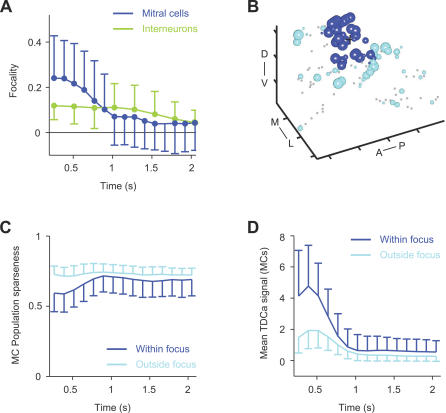
Focality of Activity Patterns and Local Sparsening(A) Mean focality (± SD) of MC and IN activity patterns as a function of time (datasets 1 and 2). Dots indicate significant differences (p < 0.05) from the focality of randomized patterns.(B) Assignment of MCs to the focus illustrated by three-dimensional activity pattern 256 ms after response onset (Lys, same as in Figure 4A; same conventions). Black cross depicts location of centroid. MCs within 50 μm from the centroid are classified as within the focus (blue); the remaining MCs are classified as outside the focus (cyan). Distance between ticks is 50 μm. Orientation is as indicated: anterior to posterior (A–P), medial to lateral (M–L), and dorsal to ventral (D–V).(C) Population sparseness of MC activity within foci (blue) and outside foci (cyan) as a function of time, averaged over all odors and OBs (± SD; dataset 1).(D) Mean TDCa signal (representing firing-rate change; arbitrary units) of MC activity within foci (blue) and outside foci (cyan) as a function of time, averaged over all odors and OBs (± SD; dataset 1).